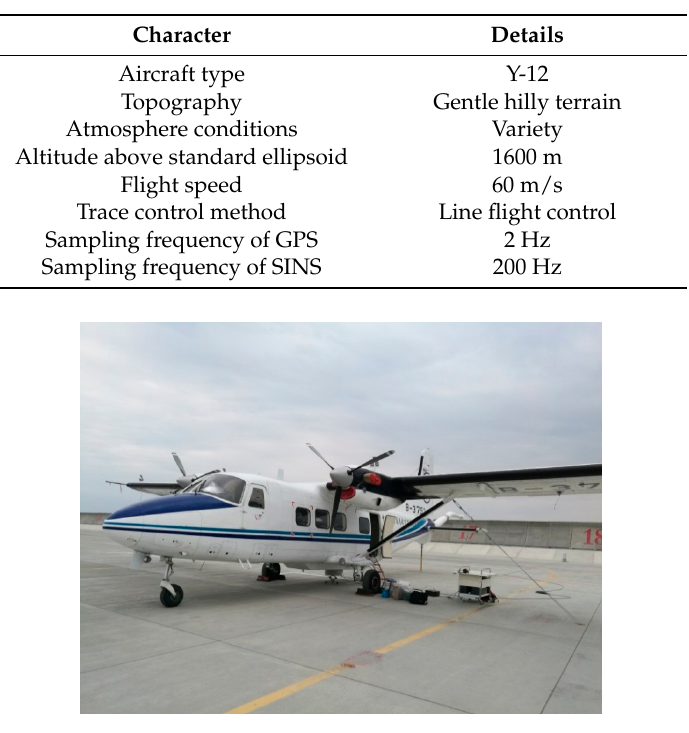
Figure 2. ( a ) The appearance of SGA-WZ02; ( b ) the SGA-WZ02 in the cabin. Table 2. The characters of flight.